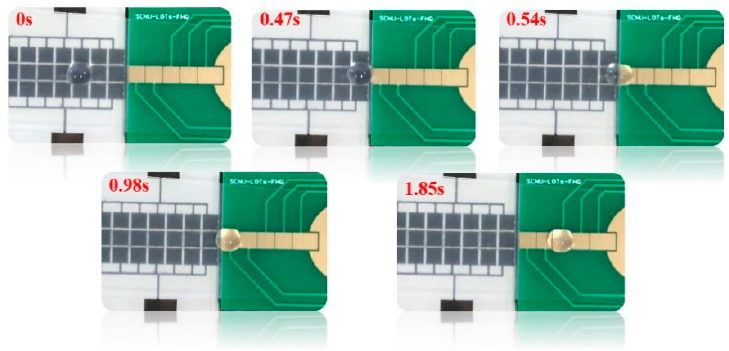
Figure 8. A video screenshot of the droplet which can be driven from the indium tin oxide (ITO) glass DMF chip to the PCB DMF